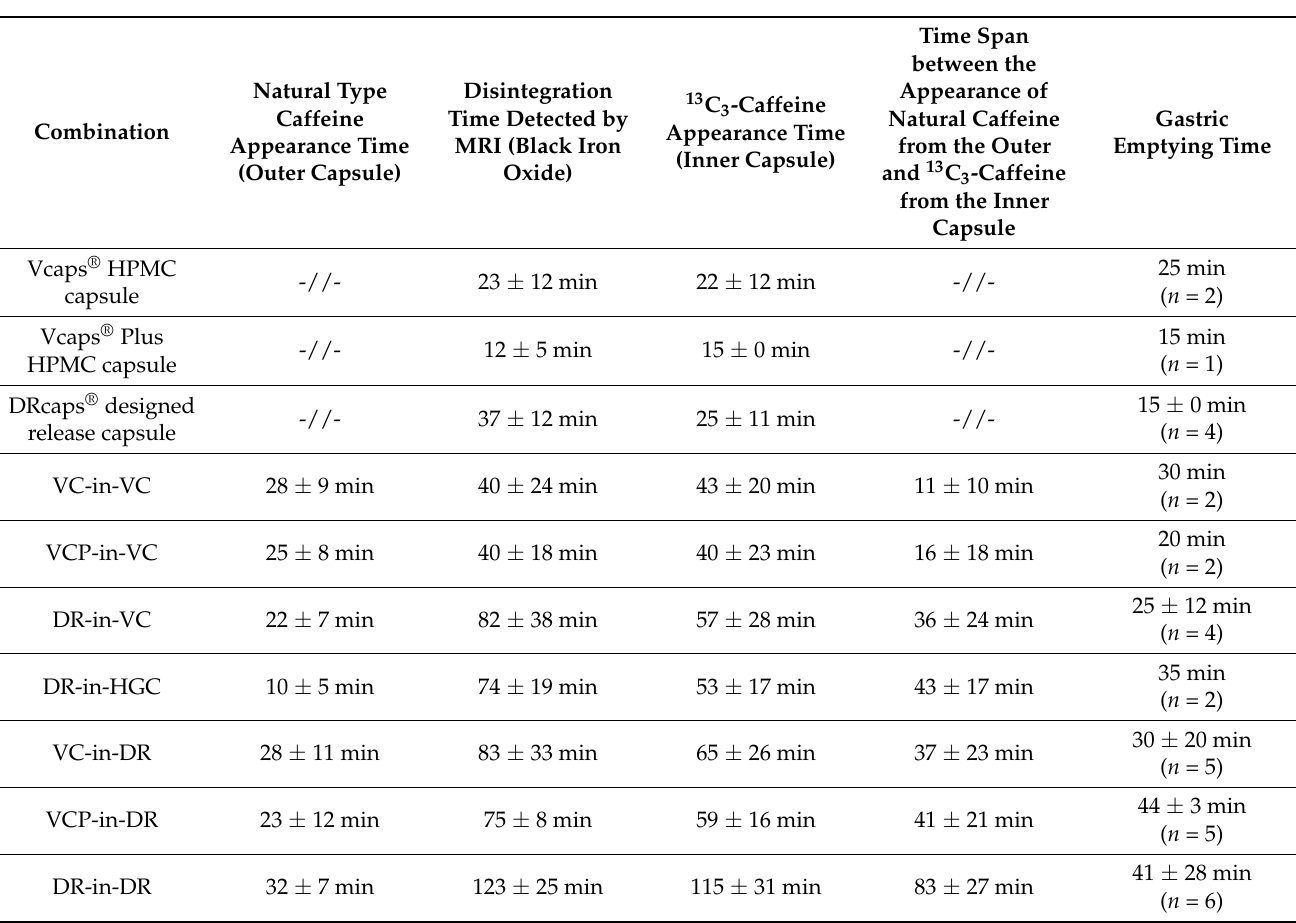
Table 4. Disintegration times of the capsules as determined by salivary caffeine and MRI, and gastric emptying times (if applicable mean ±